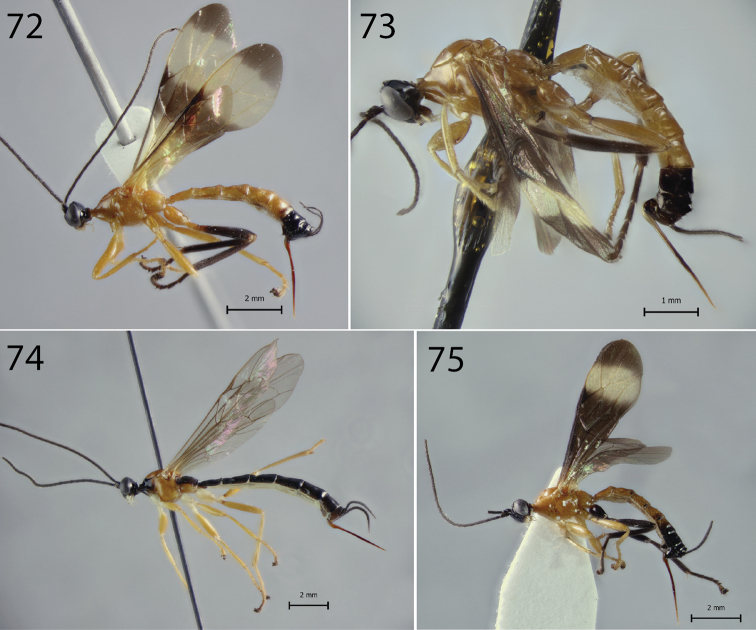
Habitus of Hymenoepimecis spp. (females), lateral view 72H.
rafaelmartinezi sp. nov. (holotype) 73H.
ribeiroi74H.
tedfordi75H.
uberensis.